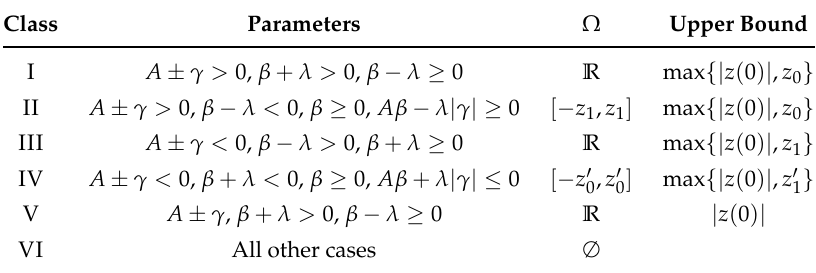
Table 1. Classification of the bounded-input bounded-output (BIBO)-stable double-loop Bouc–Wen models in Equations (1)–(4).